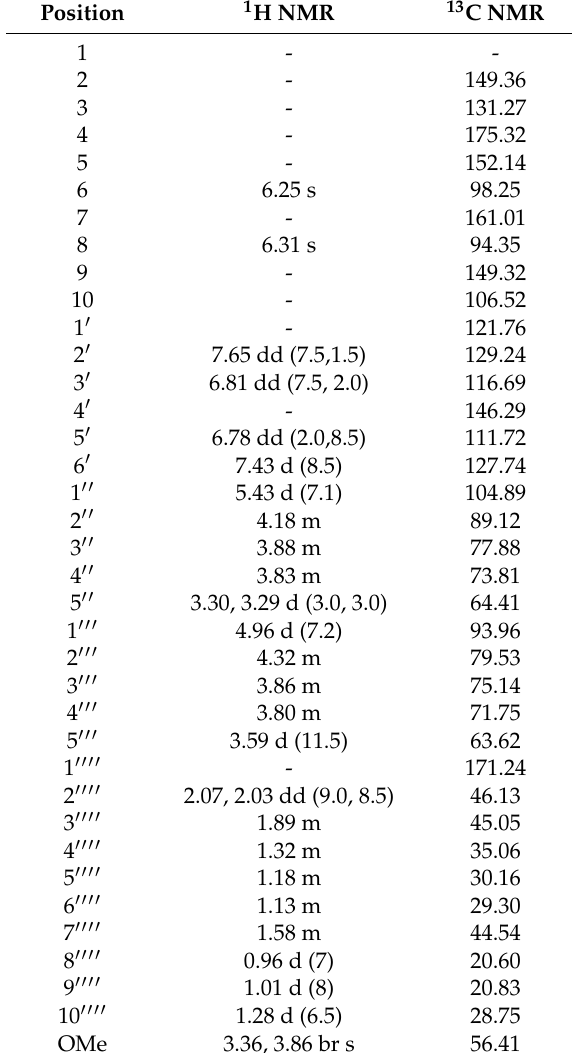
Table 1. 1 H NMR and 13 C NMR Spectroscopic data of compound 1